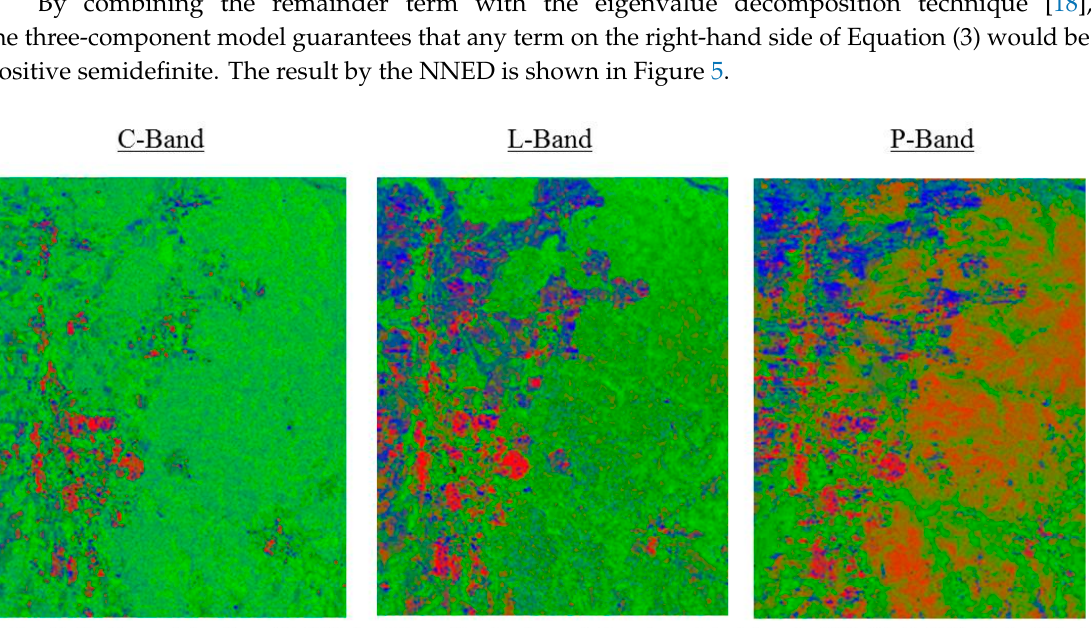
Figure 4. Pixels with negative eigenvalue are displayed using the L-band Black Forest image. The left image is the total power image at L-band, and the right image is the result of the validation test [21].